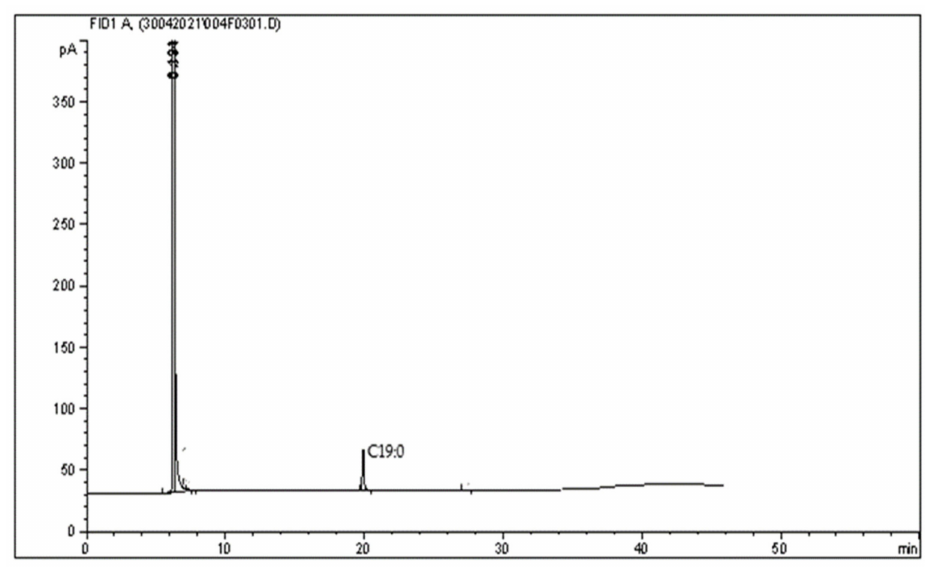
Figure 3. GC chromatogram of 1 µ L of 2.5 mg/mL methyl nonadecanoate (C19:0) standard analyzed and injected using GC. Table 5. The peak resolutions (Rs) of the DHA and EPA before and after spiking with methyl nonadecanoate standard (C19:0) in fish